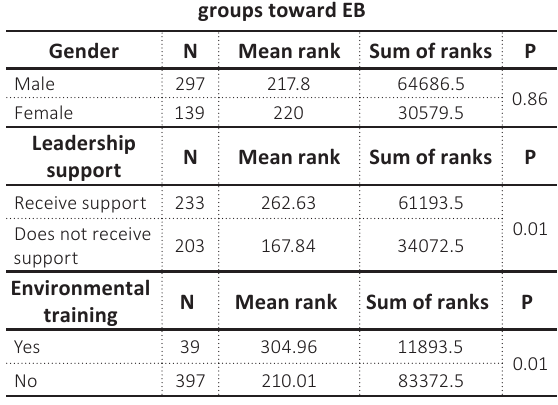
Table 3. Mann-Whitney and Kruskal-Wallis tests Mann-Whitney U test for difference between